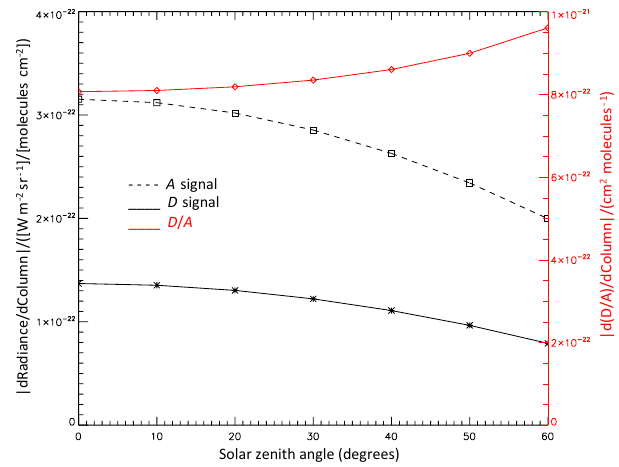
Figure 15. Variation of CHRONOS sensitivity to surface CH 4 with solar zenith angle (SZA). Absolute values for the surface layer CH 4 Jacobians are plotted for the A signal, D signal and D/A ratio as a function of